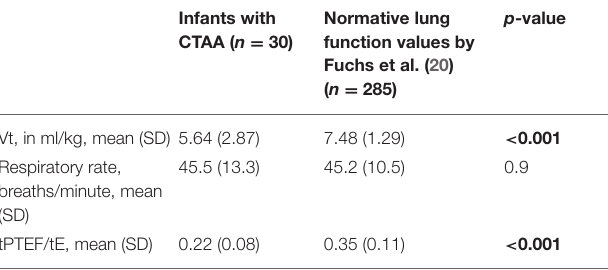
TABLE 2 | LFT measurements in infants with CTAA compared to normative lung function